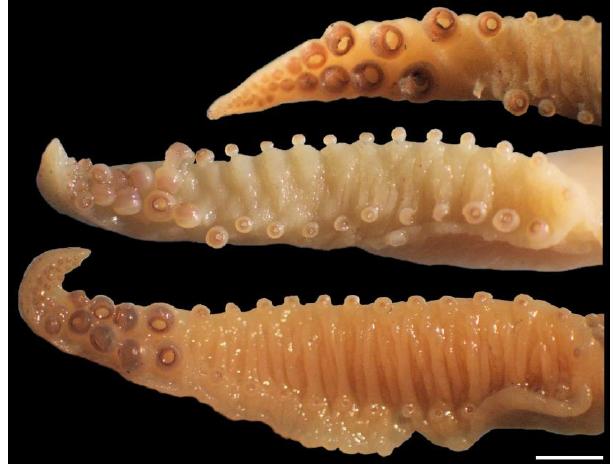
Figure 17. Sepia typica variation in hectocotylised left arm IV of males. From top to bottom: Arm-tip suckers SAIAB 211659, ML 25 mm, Northwest Area; SAIAB 211640, ML 19 mm, Northwest Area; SAIAB 211586, ML 22 mm, Eastern area. Scale bar 2 mm.